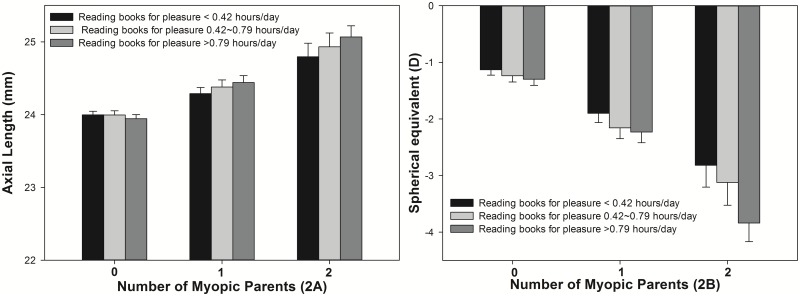
Age-gender-height adjusted axial lengths (2A, mm, mean±SEM, P = 0.04) and spherical equivalent (2B, D, mean±SEM, P = 0.05) by reading books for pleasure per week and parental myopia using general linear model.